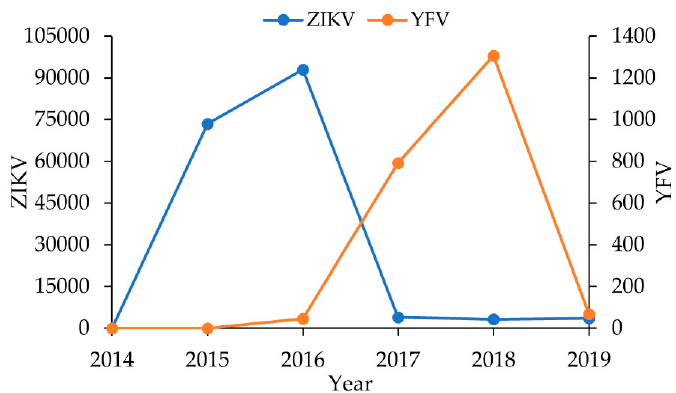
Figure 1. Number of human cases of Zika virus (ZIKV) and Yellow Fever virus (YFV) registered in Brazilian Southeast between 2014 and 2019 (https://www.saude.gov.br/boletins-epidemiologicos). In 2015, the year of the emergence of ZIKV in Brazil, there were no specific diagnostic and notification protocols. Therefore, the number of ZIKV cases showed in 2015 is an estimate for Brazilian Southeast, based in the conservative number of 440,000 cases in Brazil, in 2015, predicted by Helkeubach et al. (2016) [21].